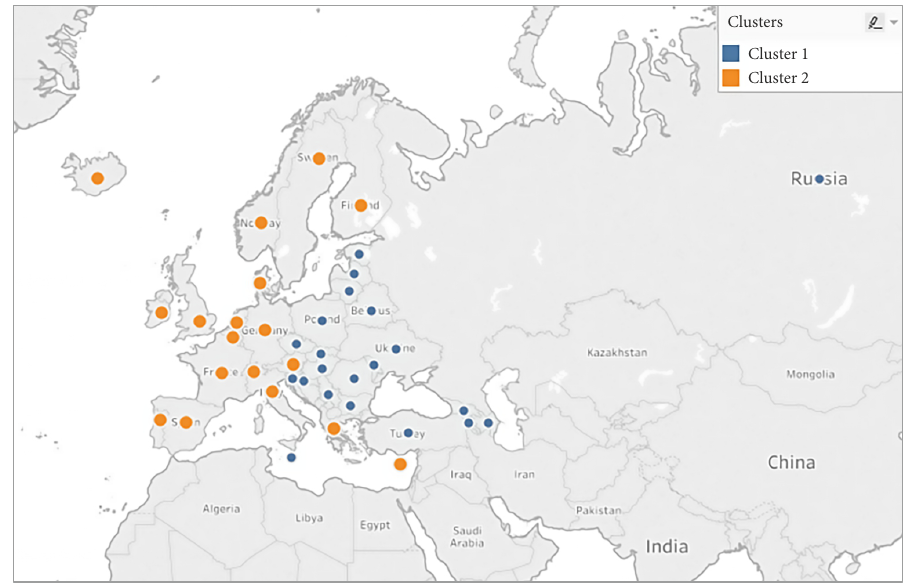
Figure 5. The two clusters based on the first principal component, development and connectivity (source: authors’ computation using Tableau Public 10.4)